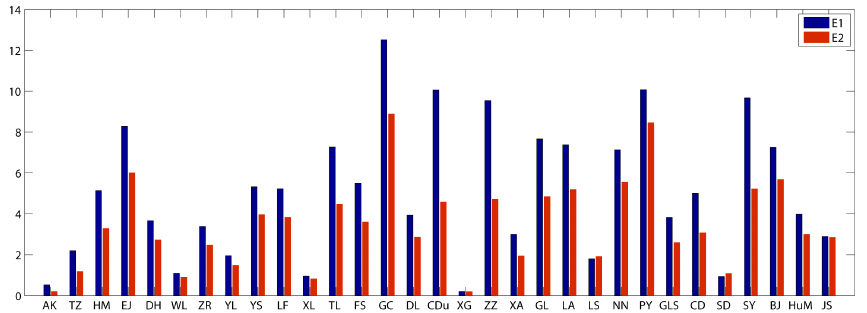
Figure 8. The root mean square error (RMSE) between the daily model simulation and observation. The blue bars show the RMSE between the daily model simulation driven by prior emissions (E1) and observations, and the red bars show the RMSE between the daily model simulation driven by inverse emissions (E2) and observations (units: µgm − 3 ).